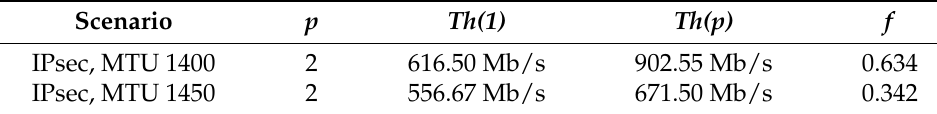
Table 1. Parallelizable fraction of L 2 S